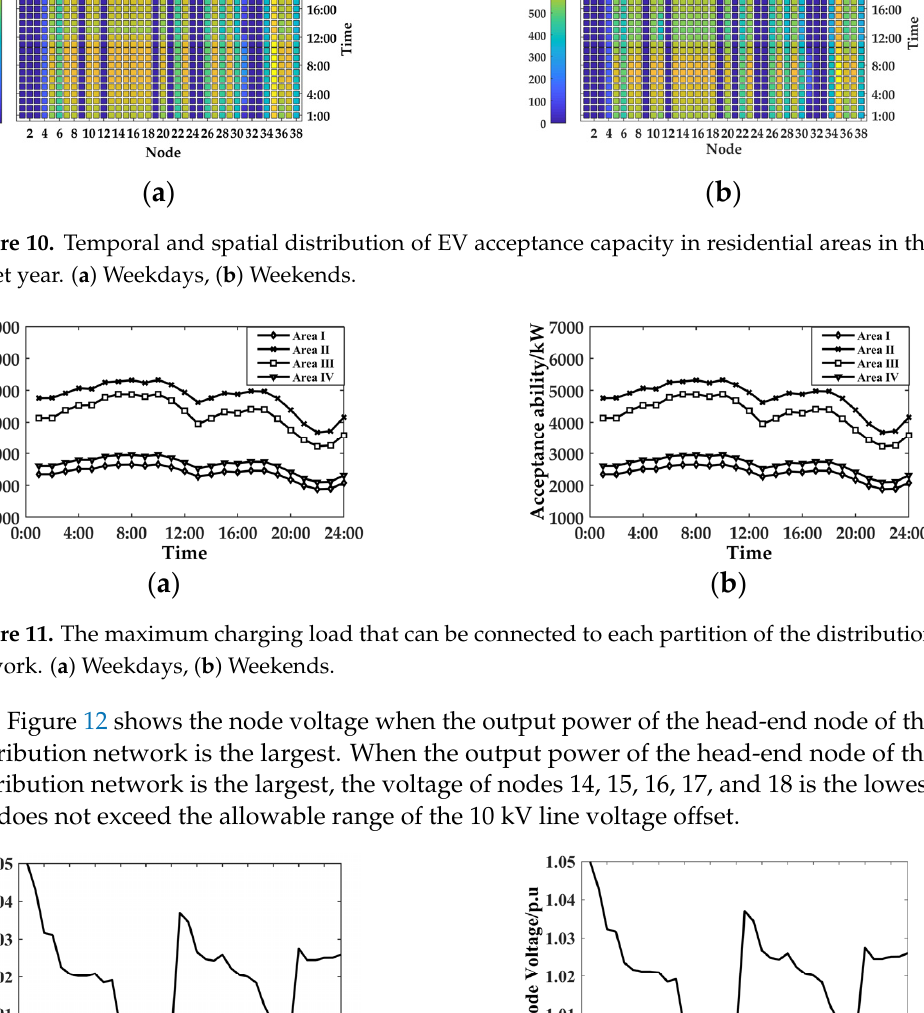
Figure 12. Node voltage at the maximum output power of node 1 of the distribution network. ( a )